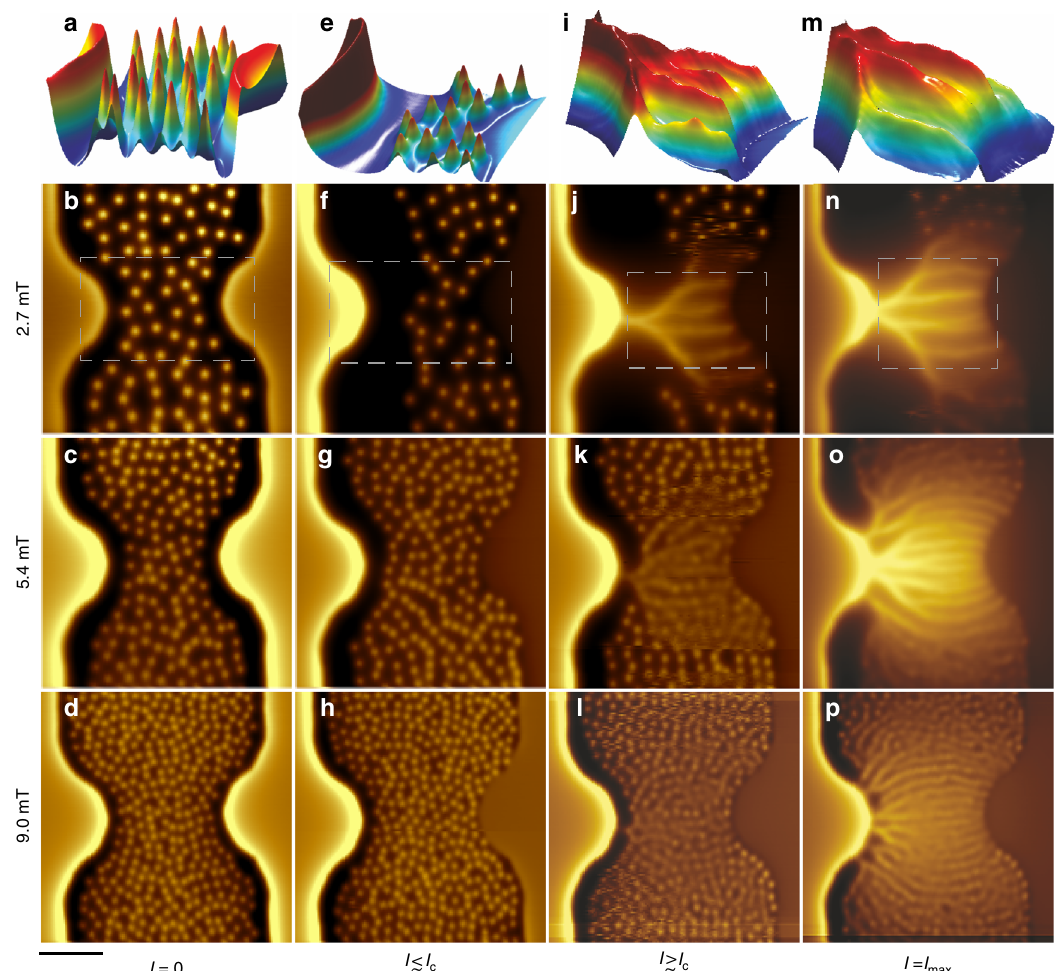
Fig. 2 Magnetic imaging of stationary and fast moving vortices in Pb fi lm at 4.2 K. a – d B z ( x , y ) SQUID-on-tip images of vortex con fi gurations at I = 0 for different values of applied fi eld B a = 2.7 a , b , 5.4 c , and 9.0 mT d . e – h Images acquired at the verge of vortex motion at I ≲ I c , at B a = 2.7 mT and I = 16 mA e , f , B a = 5.4 mT, I = 12.2 mA g , and B a = 9.0 mT, I = 6.0 mA h . i – l Images of onset of vortex fl ow at I ≳ I c at B a = 2.7 mT, I = 18.9 mA i , j , B a = 5.4 mT, I =